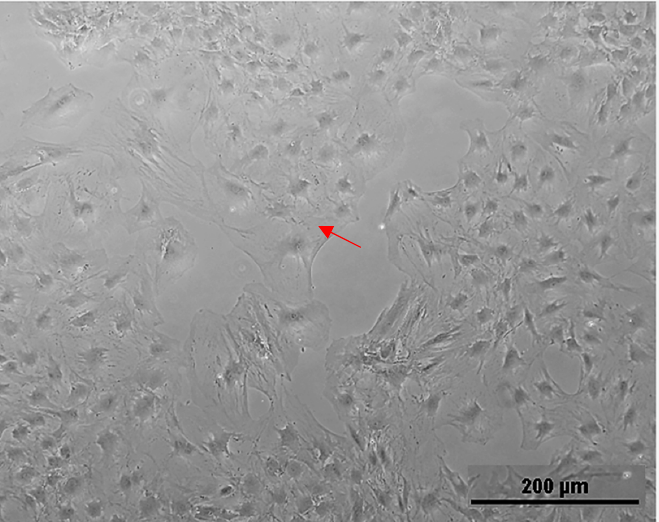
Figure 2. Cultured ROb cells showing their characteristic stellate ‐ to ‐ spindle ‐ shaped appearance, indicated with a red arrow (Scale bar = 200 μ m).